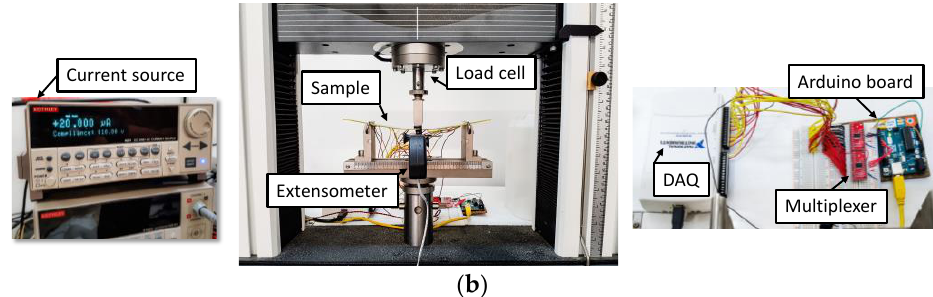
Figure 8. ( a ) Sketch of the ERT acquisition system; ( b ) instruments used for strain mapping.